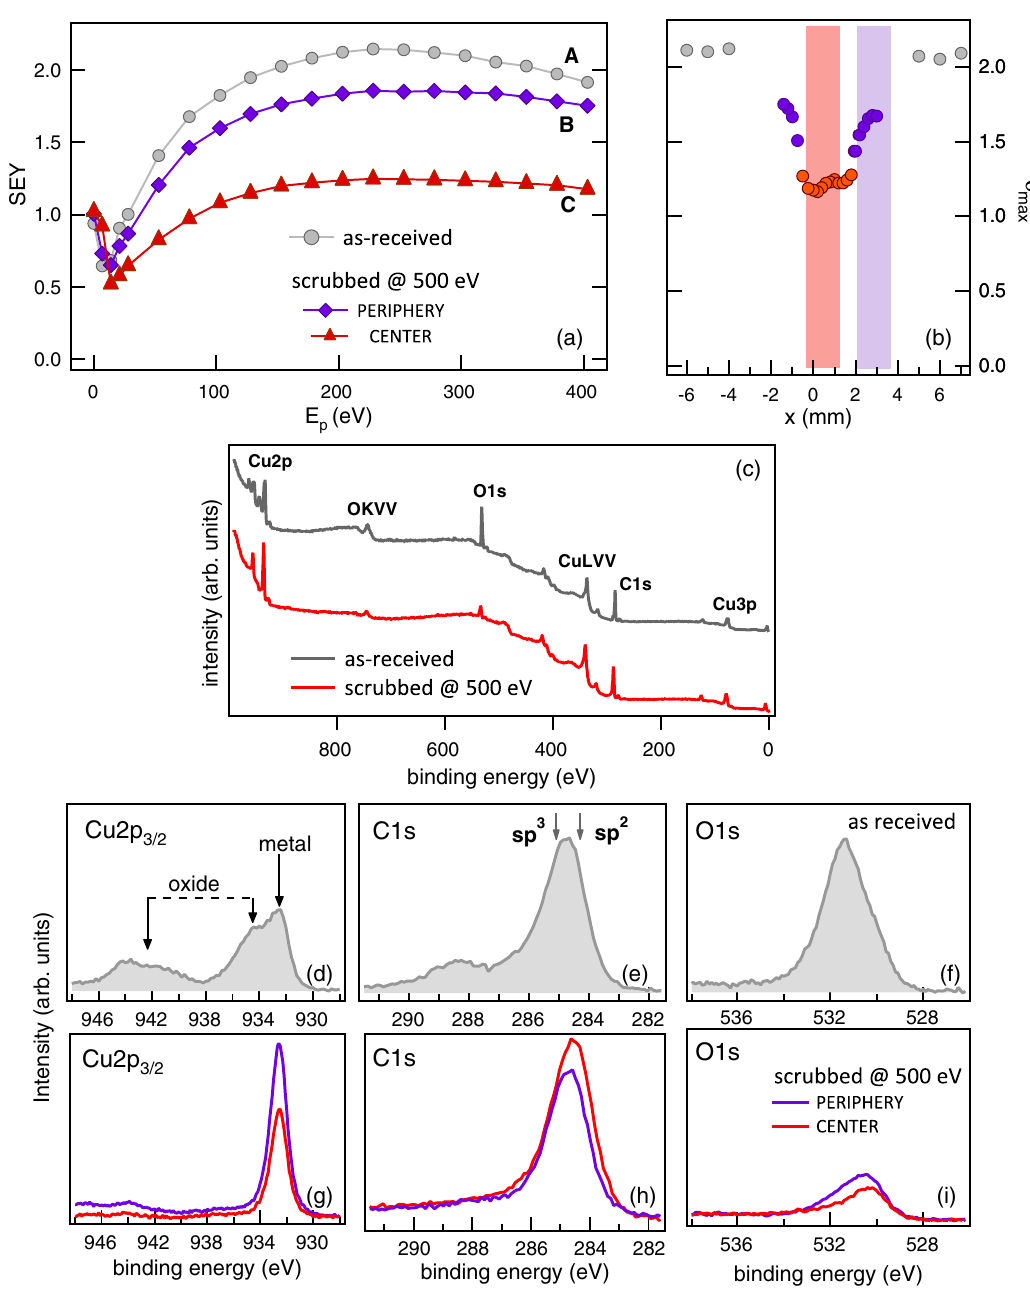
FIG. 2. (a) SEY curves measured on the as-received colaminated Cu sample for LHC beam screen (grey, circles) and in the middle (red, triangles) and in the periphery (violet, diamonds) of the sample area ( 3 (cid:3) 3 mm 2 ) scrubbed with 500 eV electrons ( 1 : 2 (cid:3) values measured along a line crossing the scrubbed region; (c) XPS spectra measured on the as-received 10 (cid:1) 3 C = mm 2 ); (b) (cid:1) max , C1s, and O1s core level spectra sample (upper curve) and in the middle of the scrubbed region (lower curve); (d)–(f) Cu2p 3 = 2 measured on the as-received sample; (g)–(i) Cu2p , C1s, and O1s core level spectra measured in the periphery (violet) and in the 3 = 2 center (red) of the scrubbed